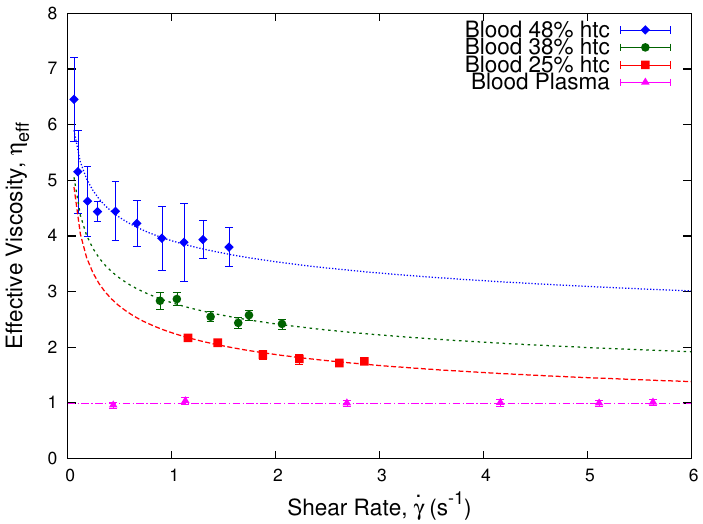
Figure 6. Effective viscosity vs. shear rate. The plot shows the effective viscosity, η ef f , which was obtained through Equation (14) as a function of the shear rate ˙ γ ( s − 1 ) . We present three different blood samples at 48%, 38%, and 25% hematocrit, from different donors: A , B , and C , respectively. The curves show the shear thinning tendencies of the three samples and the Newtonian condition of the blood plasma of the 48% hematocrit sample. As well, we observe how the effective viscosity values are affected by the hematocrit of the samples. The dashed lines are a guide to the eye, which are obtained through Equation